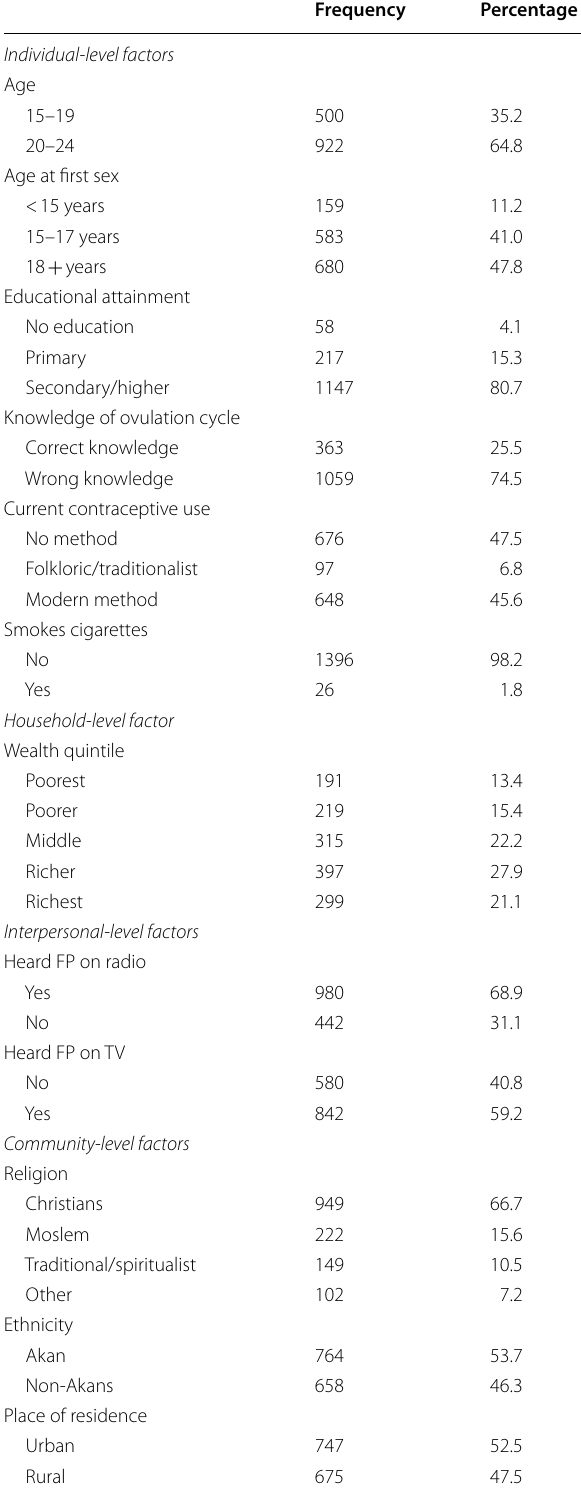
Table 1 Socio-demographic characteristics of study